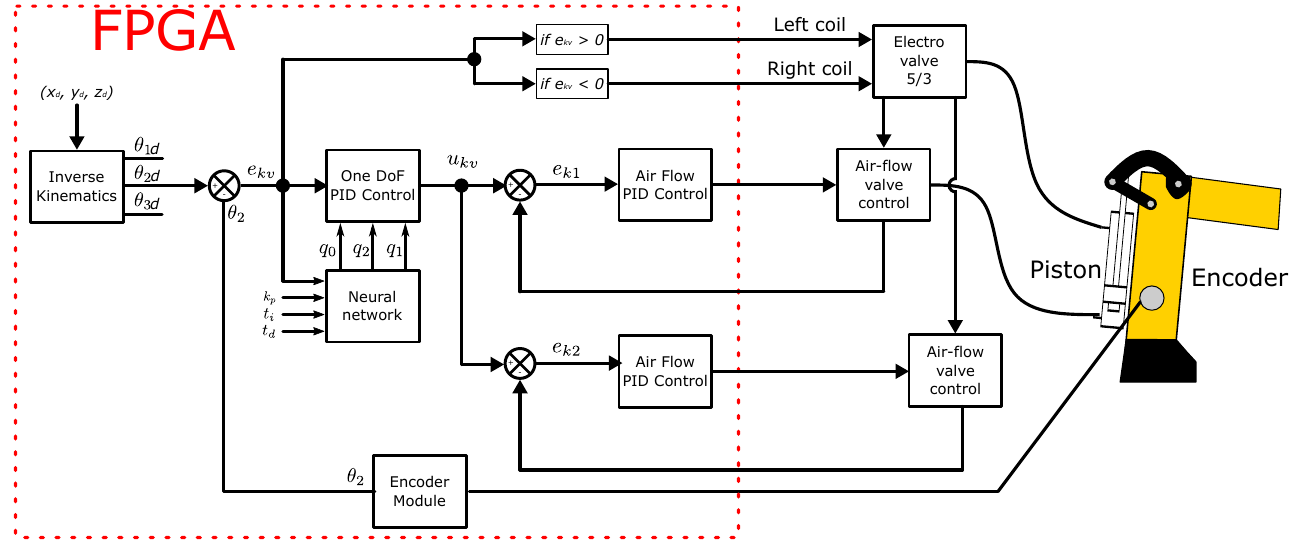
Figure 16. General diagram for a DoF.